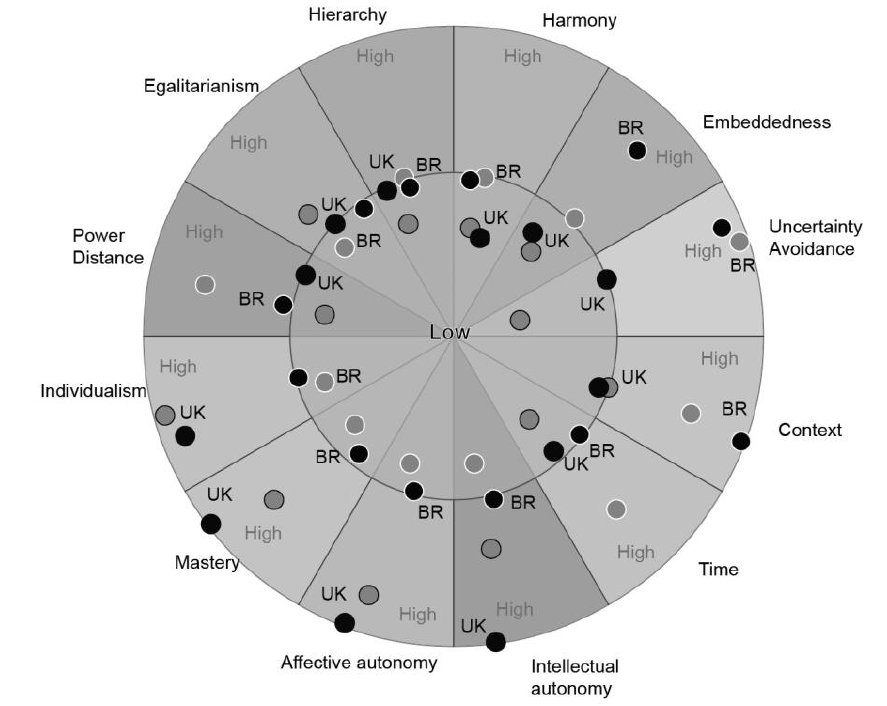
Figure 2 Cultural map after the study, comparing Brazilian and British cultural dimensions (grey dots: before the study; black dots: after the